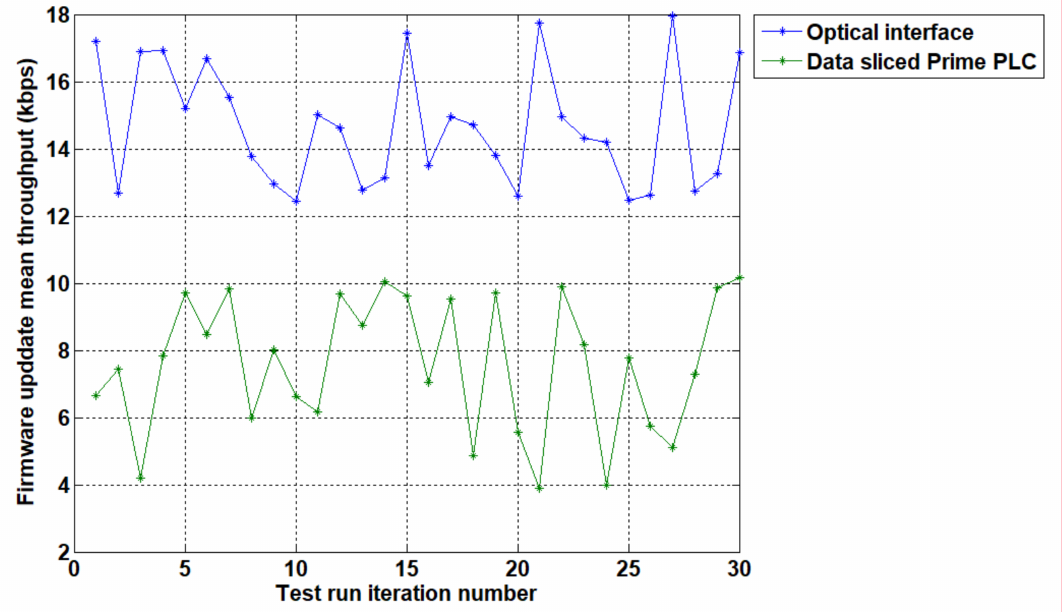
Figure 9. Visual representation of the firmware upgrade throughput test results for 1 MB files through both optical and sliced PRIME PLC communication.